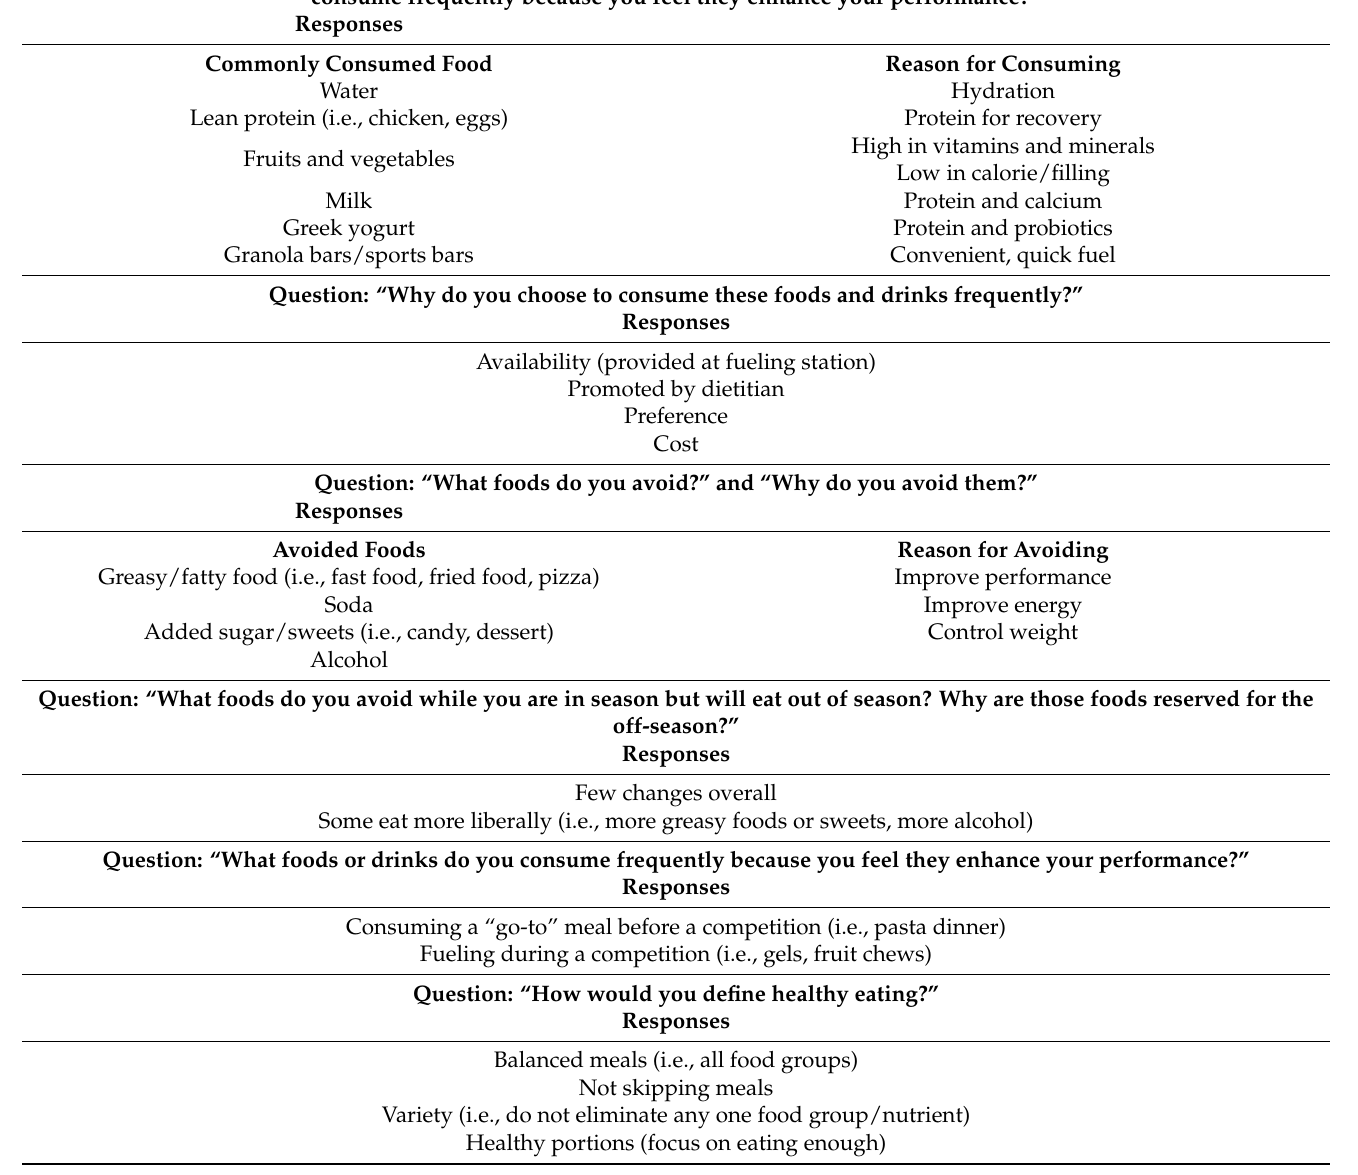
Table 1. Semi-structured Interview Items and Summary of Eating Behaviors of Division I Athletes (n = 14). Question: “What foods or drinks do you consume every day or almost every day?” and “What foods or drinks do